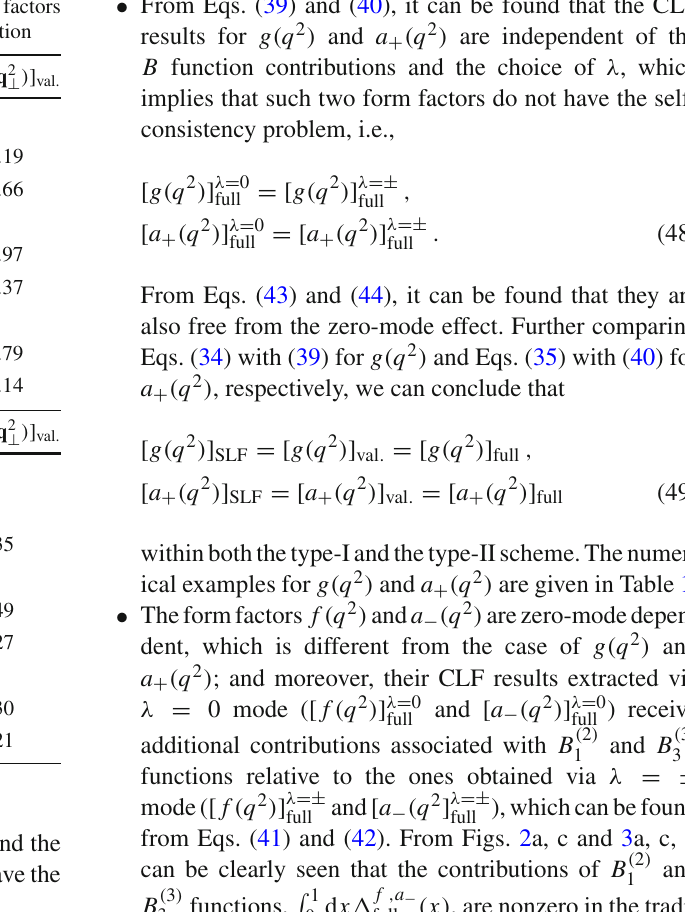
Fig. 2 The dependences of ( x ) and d [ f , a − ] (cid:17) f , a − full